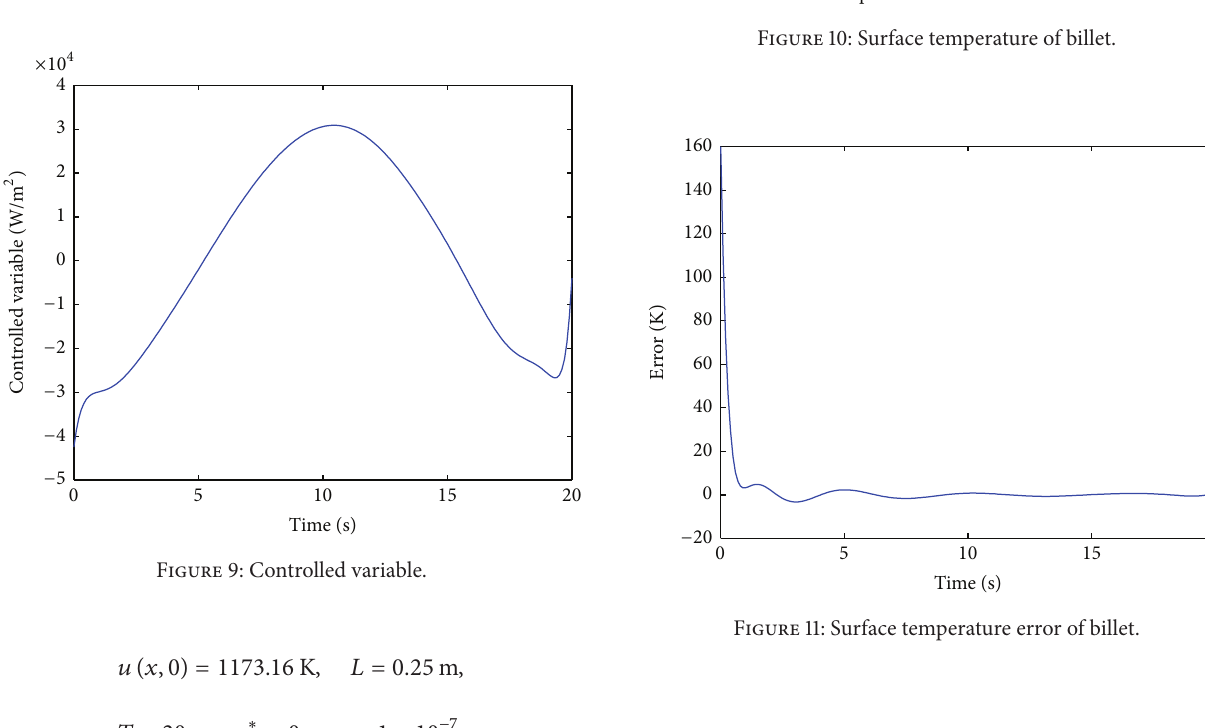
Figure 8: Surface temperature error of billet.